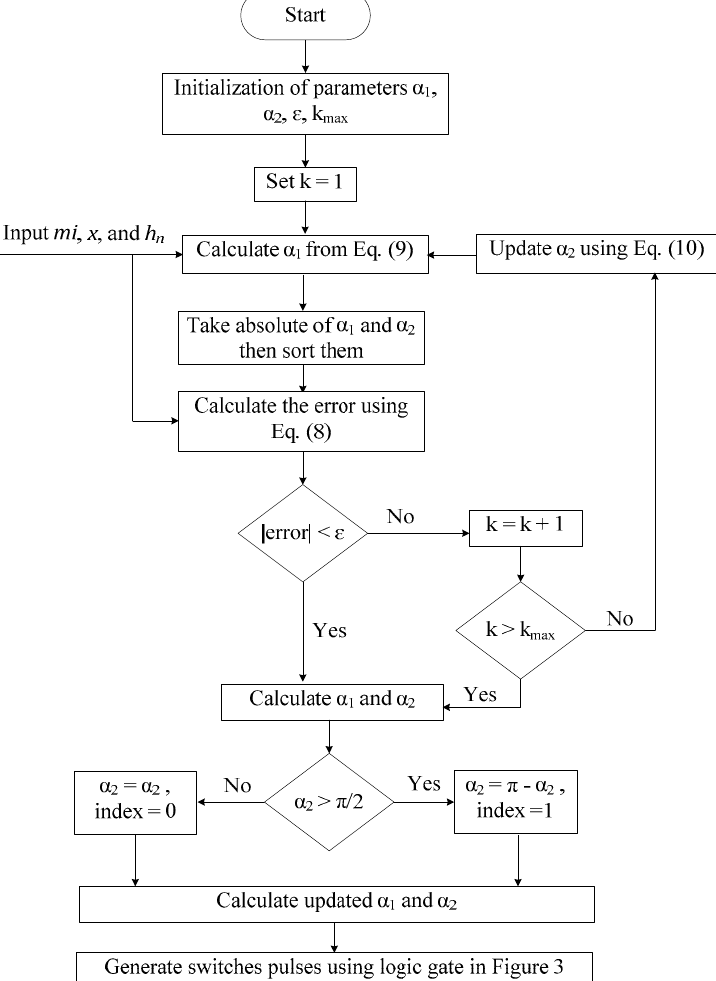
Figure 2. Flow chart of the proposed solution.